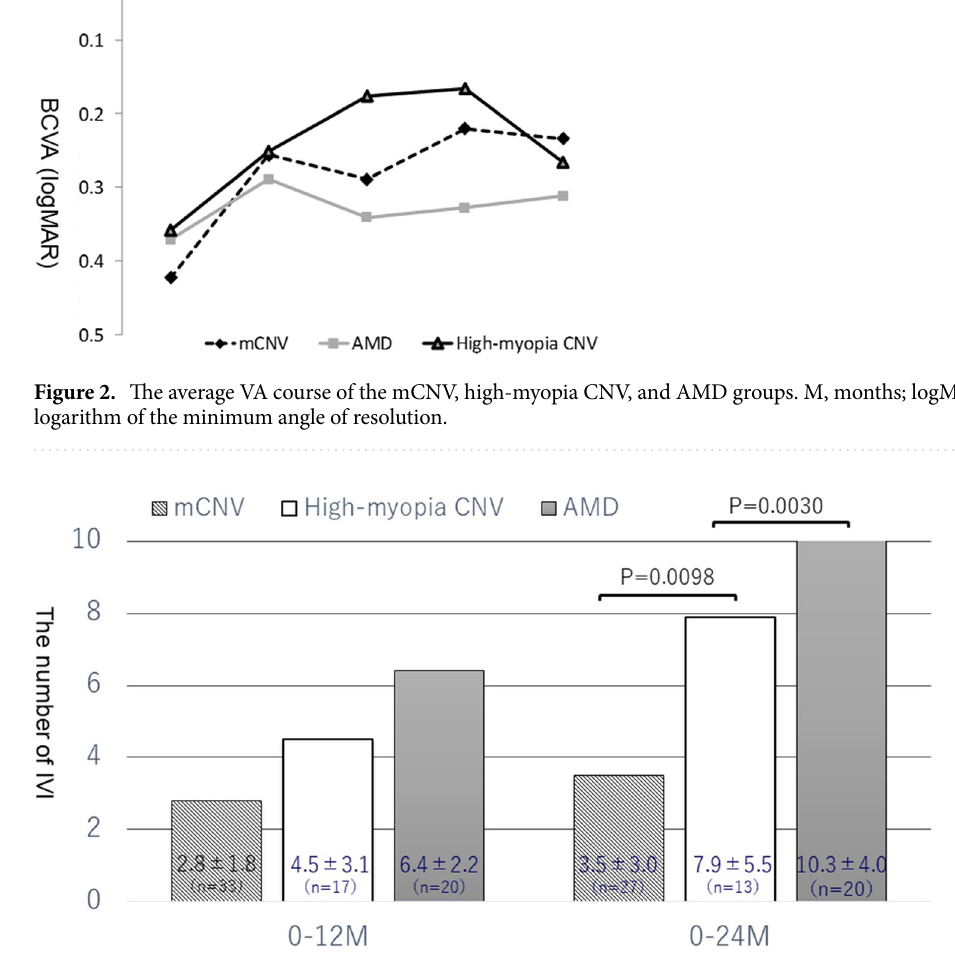
Figure 3. The average number of intravitreal injections in the mCNV, high-myopia CNV, and AMD groups. M, months; IVI, intravitreal